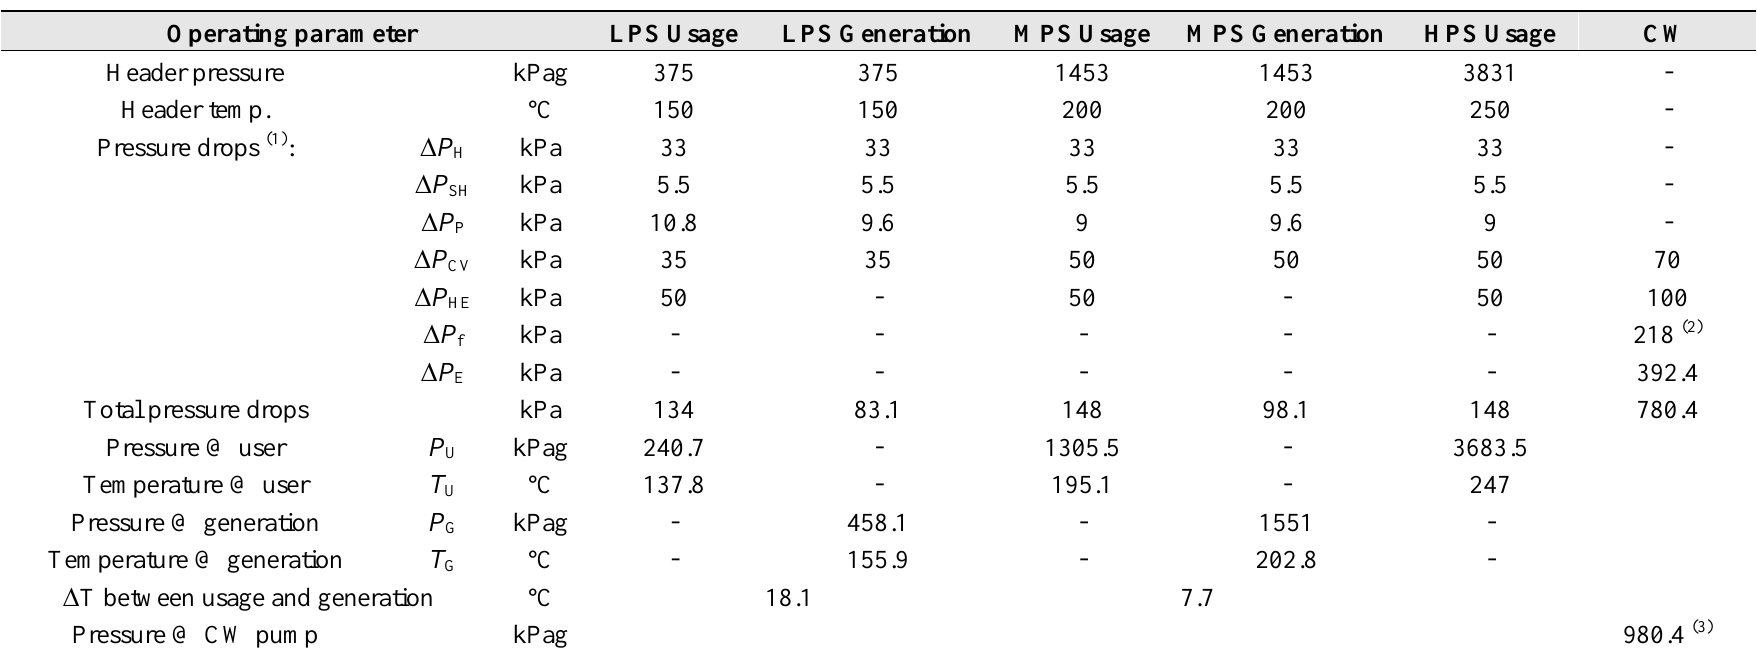
Table 3. Summary of pressure drops estimation for steam and CW distribution